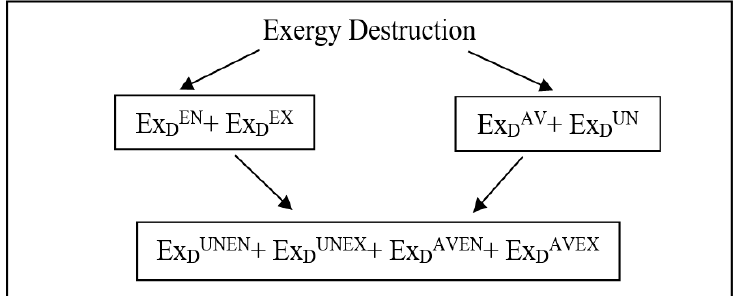
Figure 3. A schematic subdivision of exergy destruction [63].